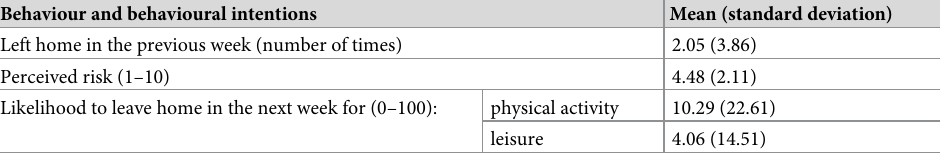
Table 3. Descriptive statistics for the reported behaviour and behavioural intentions concerning the